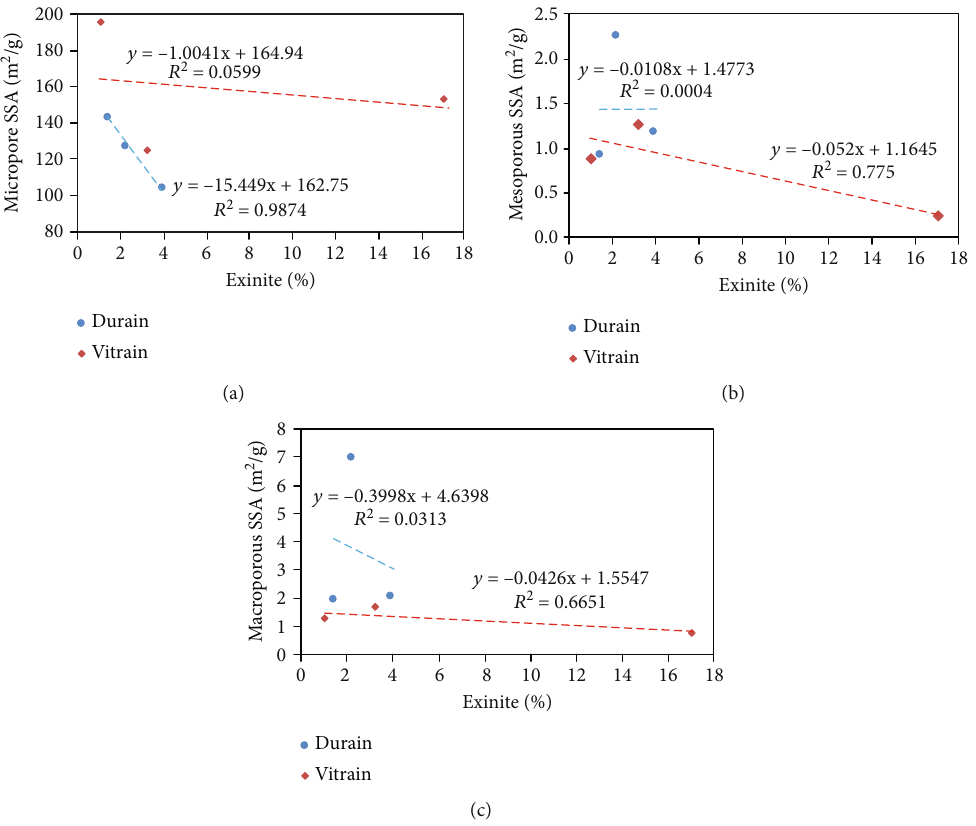
Figure 15: Correlation between exinite content and SSA. (a) Micropore; (b) mesopore; (c)